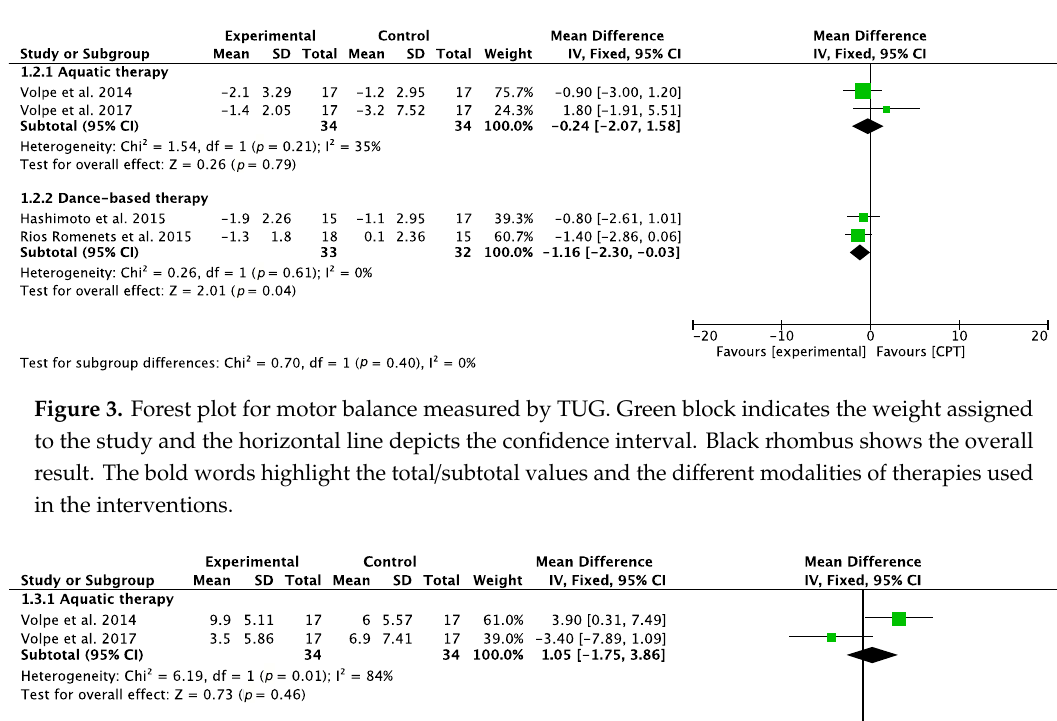
14 of 20 Figure 2. Forest plot for motor function measured by UPDRS-III. Green block indicates the weight assigned to the study and the horizontal line depicts the confidence interval. Black rhombus shows